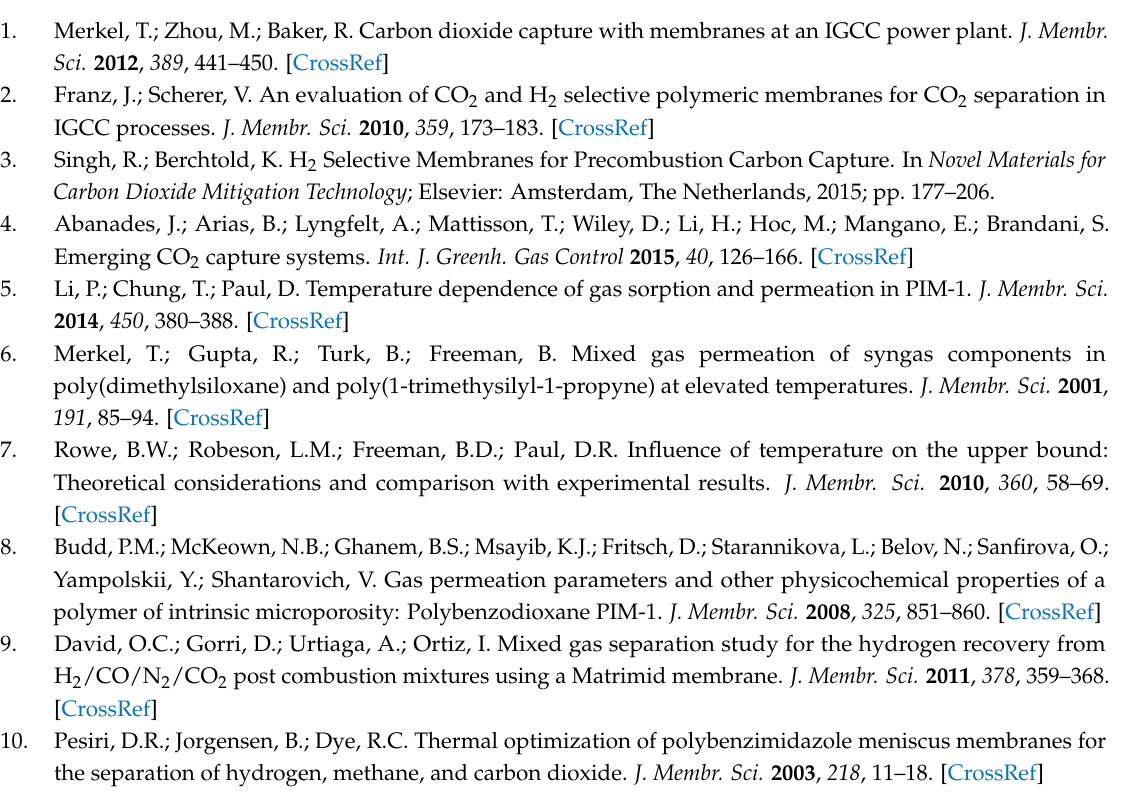
Table S1: Gas permeability coefficients of N 2 , CO 2 , H 2 and CH 4 for temperatures between 30 ◦ C and 200 ◦ C and pressure between 1 bar and 20